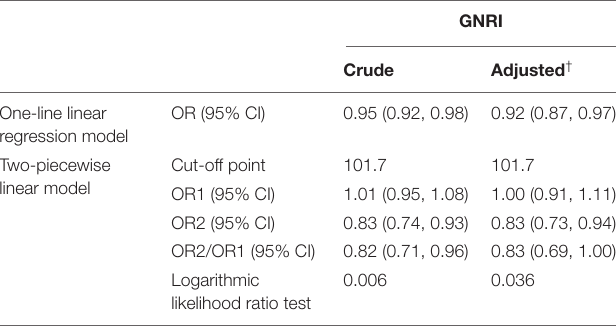
TABLE 2 | Cut-off point of GNRI before and after adjustment of the effect